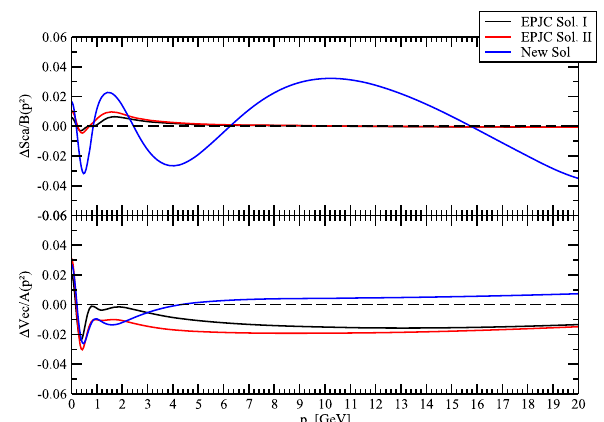
Fig. 2 Relative error for the Schwinger–Dyson equations for the solu- tions I and II reported in [4] for α s = 0 . 22 and the new solution consid- ered here, computed using Padé approximants and taking into account thesoft-gluonlimit.Inbothsolutionsthepropagatorswererenormalised at μ = 4 . 3 GeV using the